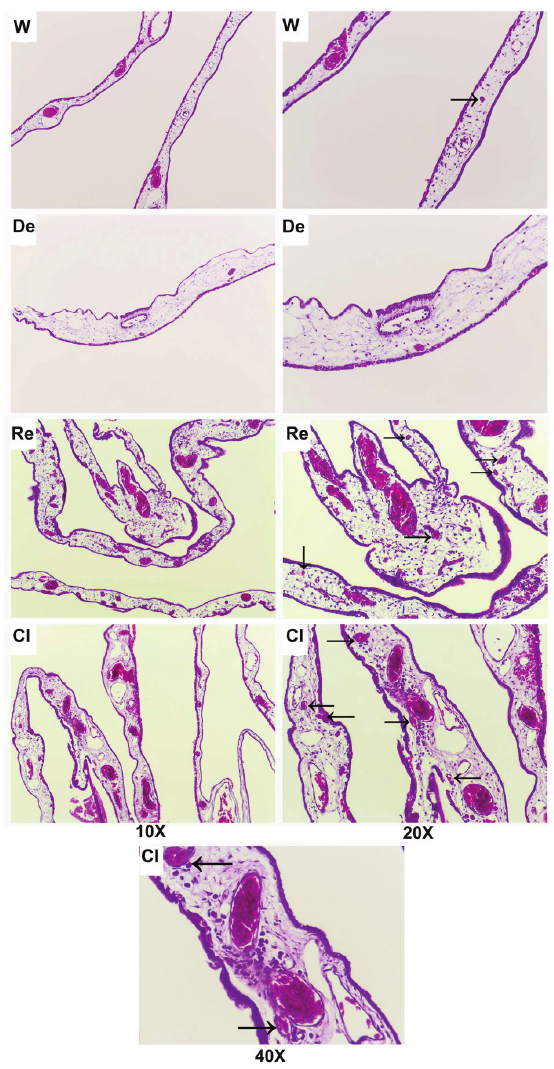
Figure 3 - Paraffin sections stained with hematoxylin- eosin with 10, 20 and 40x magnification. W: neutral control (distilled water); De: inhibitor control (dexamethasone); Re : positive control (Regederm  ); Cl: C. longa essencial oil (Cl). The arrows show neovascularization. Inflamatory elements are visualized as purple dots. Those elements were found more frequently in Re and Cl. Hyperemia is identified by high erythrocytes concentration (Re and